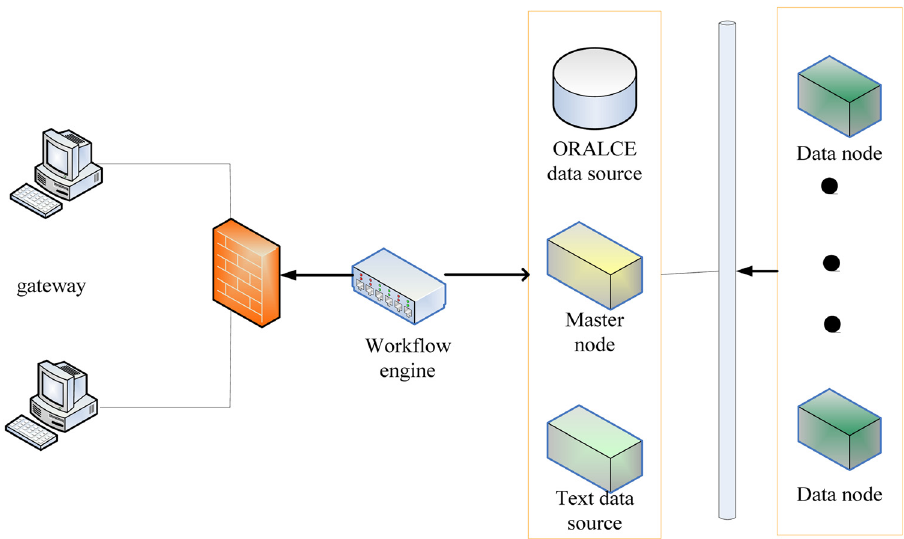
Figure 7: Platform topology